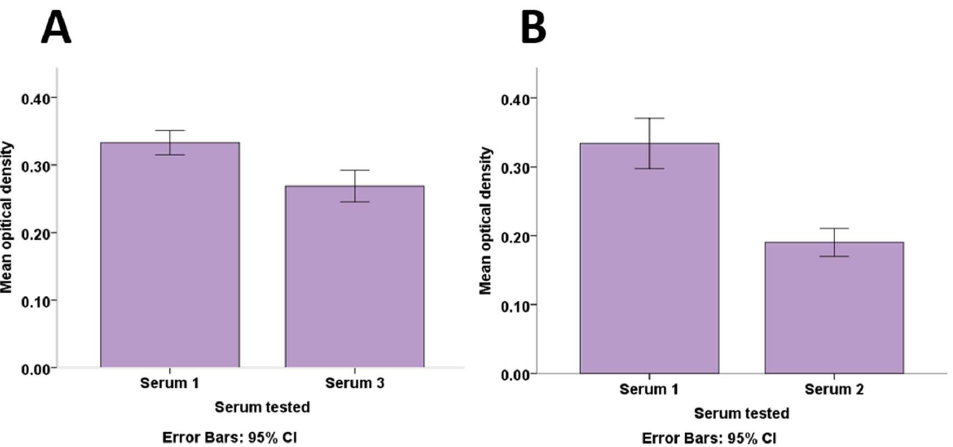
Figure 6. Comparison of mean optical density values of HCoV-NL63-rIFA-positive (Serum 1) and HCoV-NL63-rIFA-negative (Serum 2 and 3) sera also positive for HCoV-229E (Serum 3) (Panel ( A )) and HCoV-OC43 (Serum 2) (Panel ( B )) showing a difference between the positive and negative test sera. Error bars indicate a 95% confidence